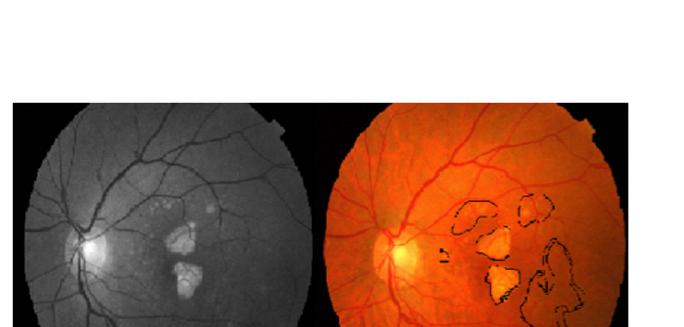
Fig 3. Segmentation of reticular pseudodrusen. A) original fundus photograph with large area containing both reticular macular disease (reticular pseudodrusen) and ordinary soft drusen outlined in black. The soft drusen are confined to the central macula. The reticular pseudodrusen extend to the arcades. B) original color fundus photo C) both reticular pseudodrusen and soft drusen are segmented (green) on the color photo within the area identified in A and within the superimposed Wisconsin grading template. D) The area of reticular macular disease is separately enclosed in red, and was excluded from drusen measurements.